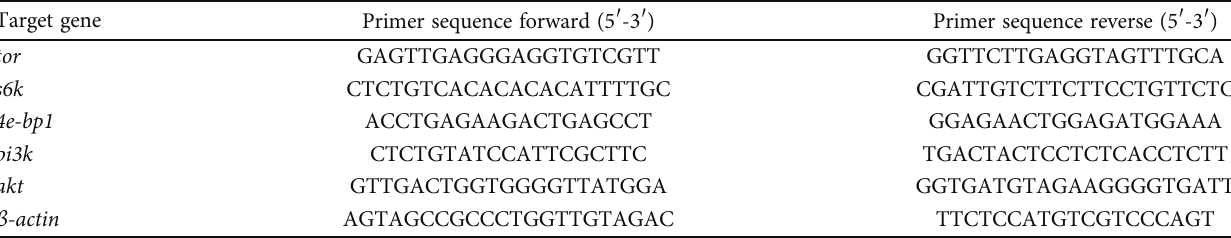
Table 3: Primer sequences of target genes in real-time PCR